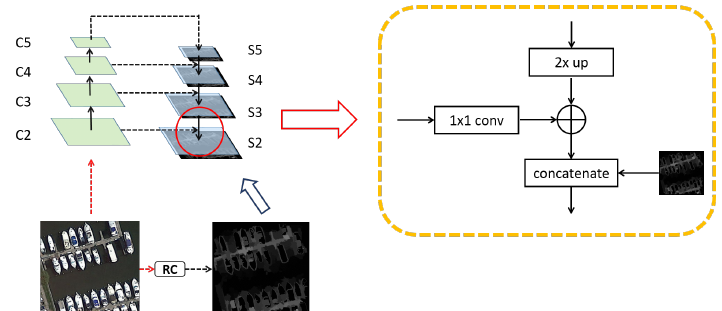
Figure 7. The construction process for the saliency